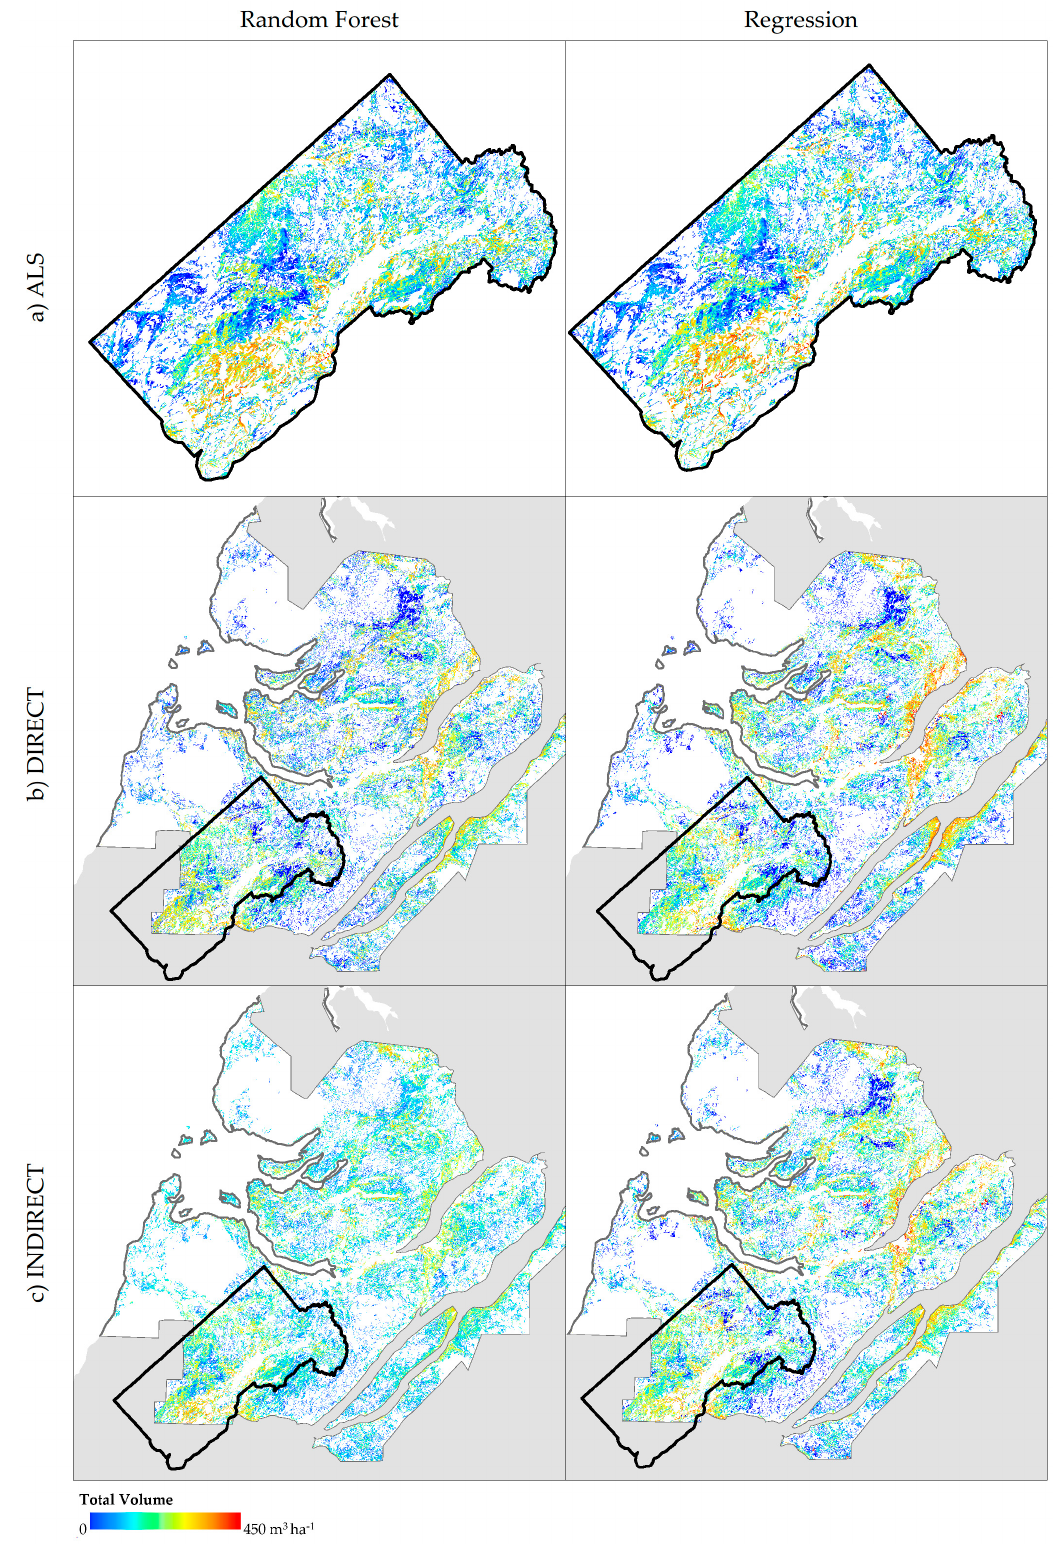
Figure 4. Illustrative maps of total volume (m 3 ha − 1 ) predicted with ( a ) ALS, ( b ) direct and ( c ) indirect modeling approaches. The corresponding ALS area is outlined in black.